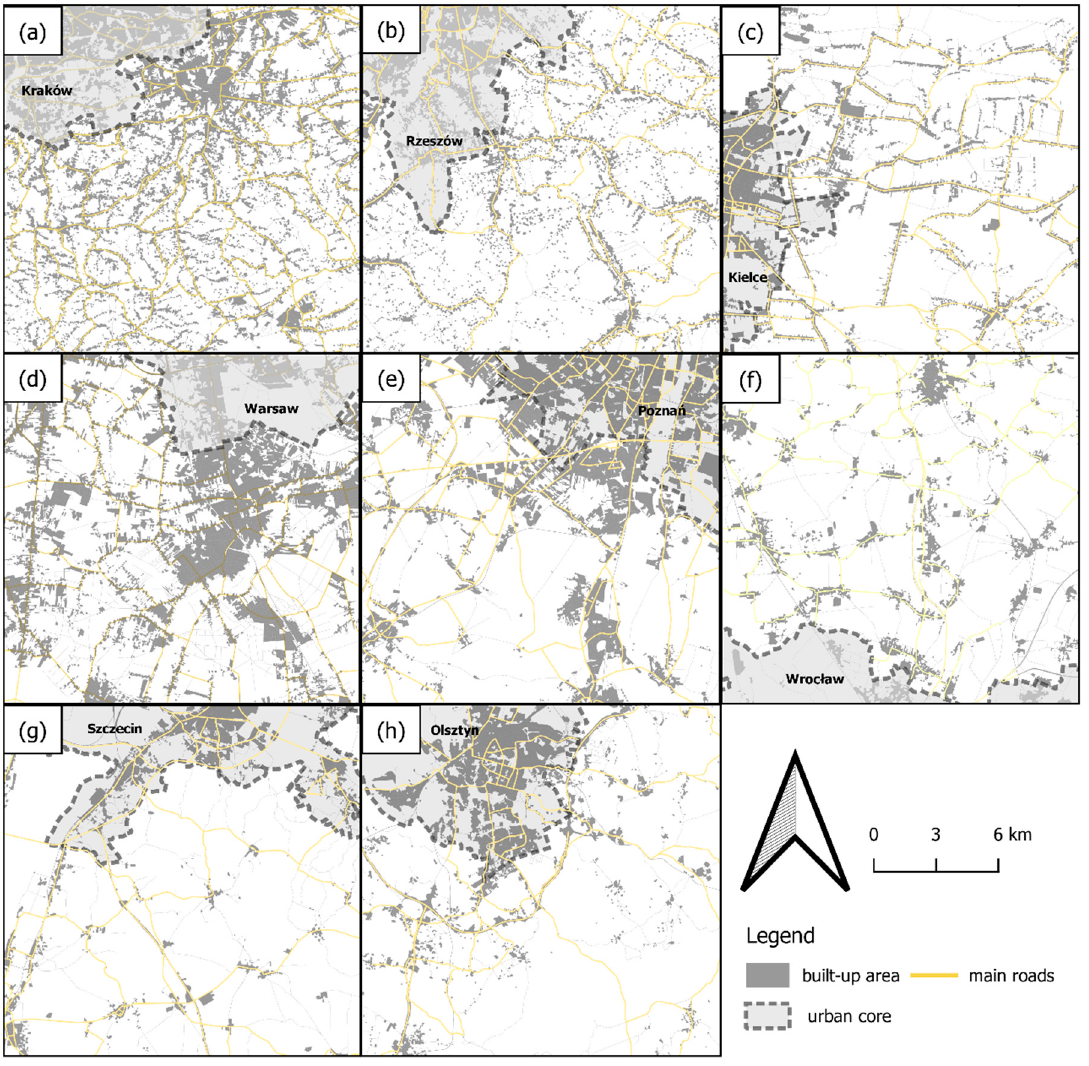
Figure 4. Examples of regional variation of urban sprawl forms: ( a ) scattered development in the FUA of Krakow ( a ) and in the FUA of Rzesz ó w ( b ), ribbon development in the FUA of Kielce ( c ), edge expansion in the FUA of Warsaw ( d ) and in the FUA of Pozna´n ( e ), leap frog development in the FUA of Wrocław ( f ), development based on previously existing villages in the FUA of Szczecin ( g ) and in the FUA of Olszyn ( h ).